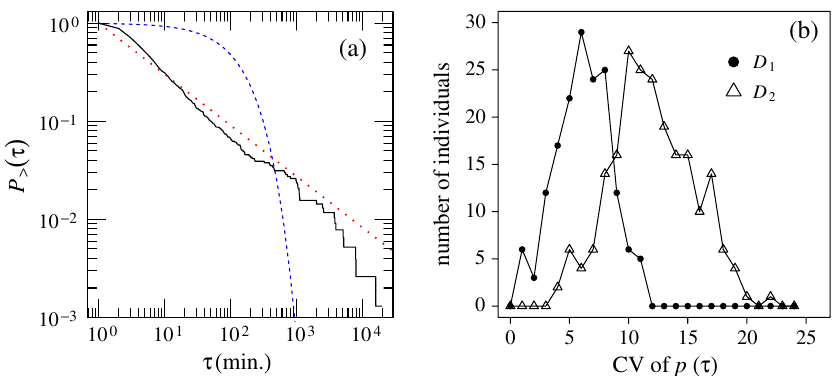
FIG. 13. (a) Cumulative distribution of the interevent intervals of a typical individual in D power-law fit with exponent (cid:3) 1 : 52 , which was obtained from the maximum likelihood test [47]. The dashed line represents the exponential distribution with the same mean as that of the data. (b) Distributions of the CV of p ð (cid:1) Þ in D